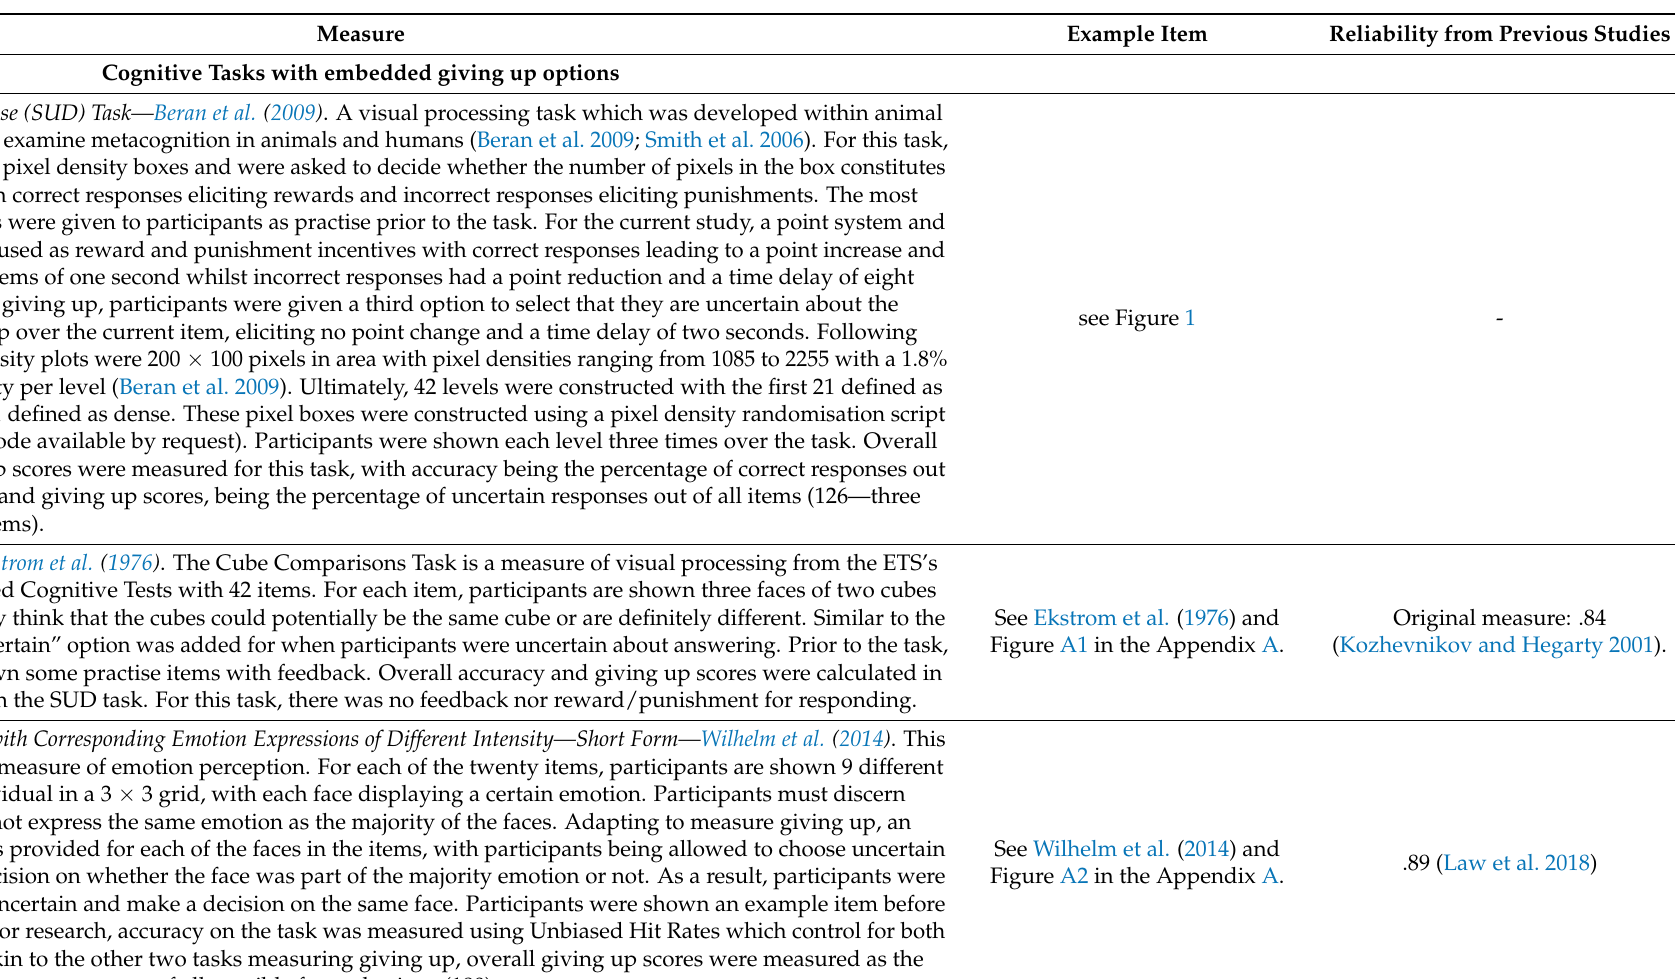
Table 1. Summary of measures used in this study.